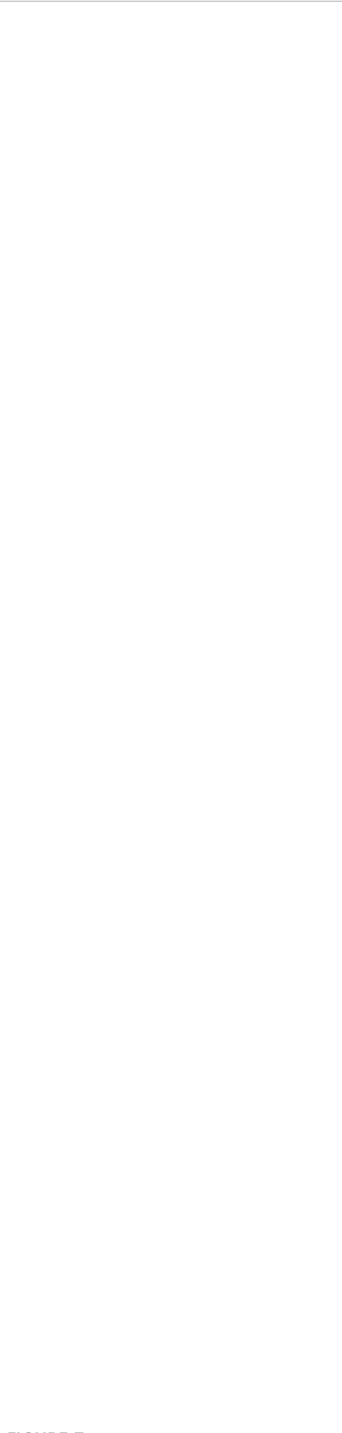
FIGURE 7 Simulation diagram of P-Z wetting model (A) Result of 800 kPa (B) Result of 1,600 kPa (C) Result of 2,400